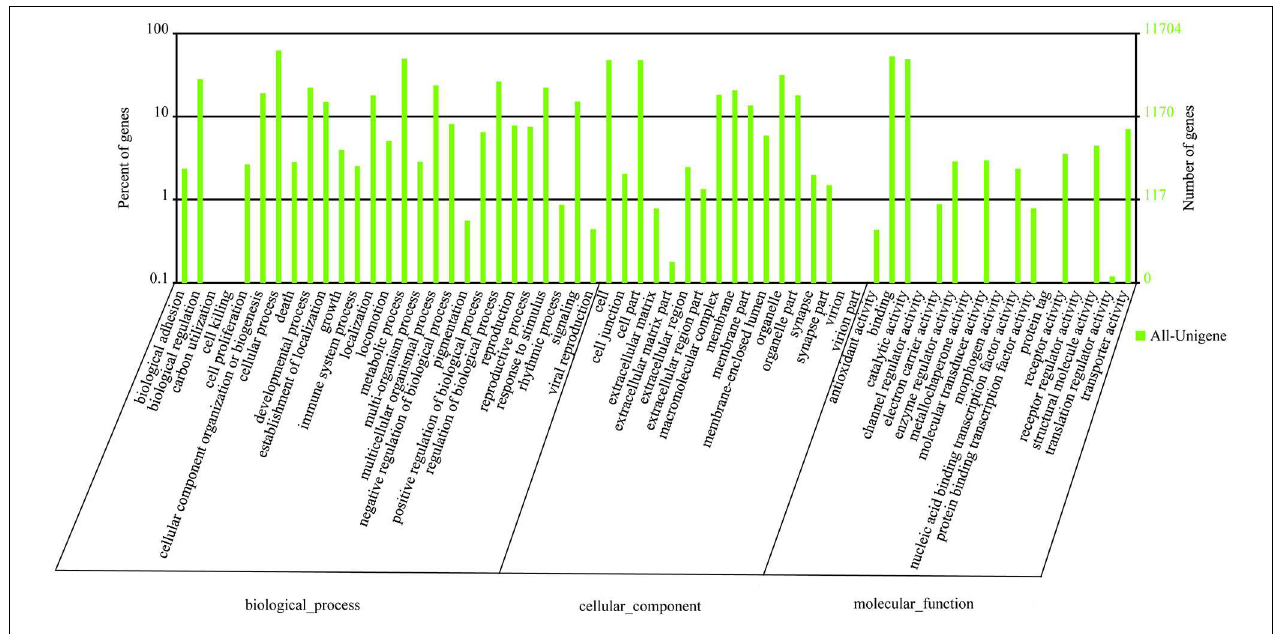
FIGURE 2 | Gene ontology distributions of L. decemlineata unigenes annotated at GO level 2. The Y-axis shows the percentage and number of annotated GO terms in three categories: biological process, cellular